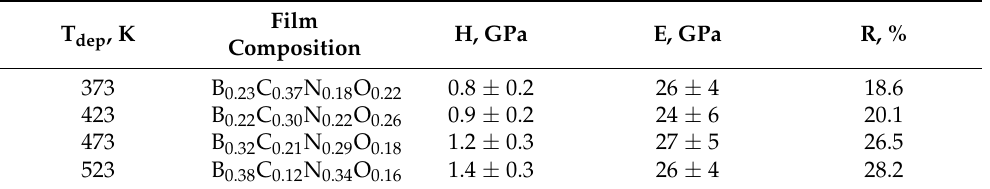
Table 8. Mechanical properties of PECVD BC x N y O z films.